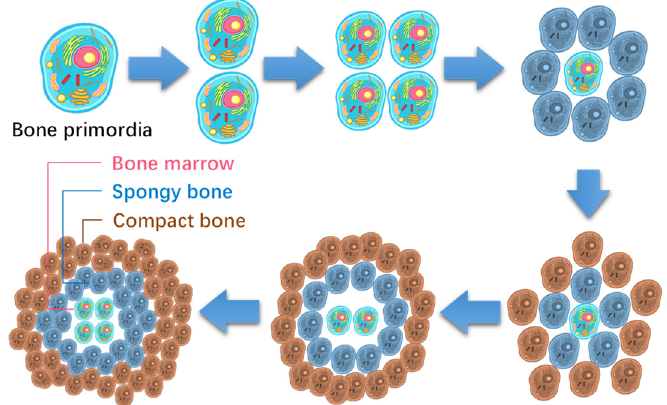
Figure 5. Formation process of hand bones from a primary cell within six steps of division.